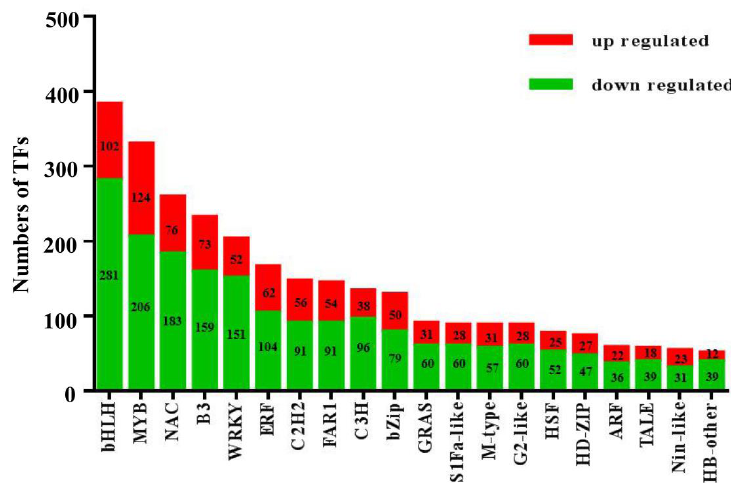
Figure 6. The number of transcription factors involved in the top 20 transcription factor families. The x-axis represents the numbers of transcription factors, and the y-axis represents the top 20 transcriptions. The 2854 TF genes were divided into 20 families, of which 932 were up-regulated and 1922 down-regulated. and 1922